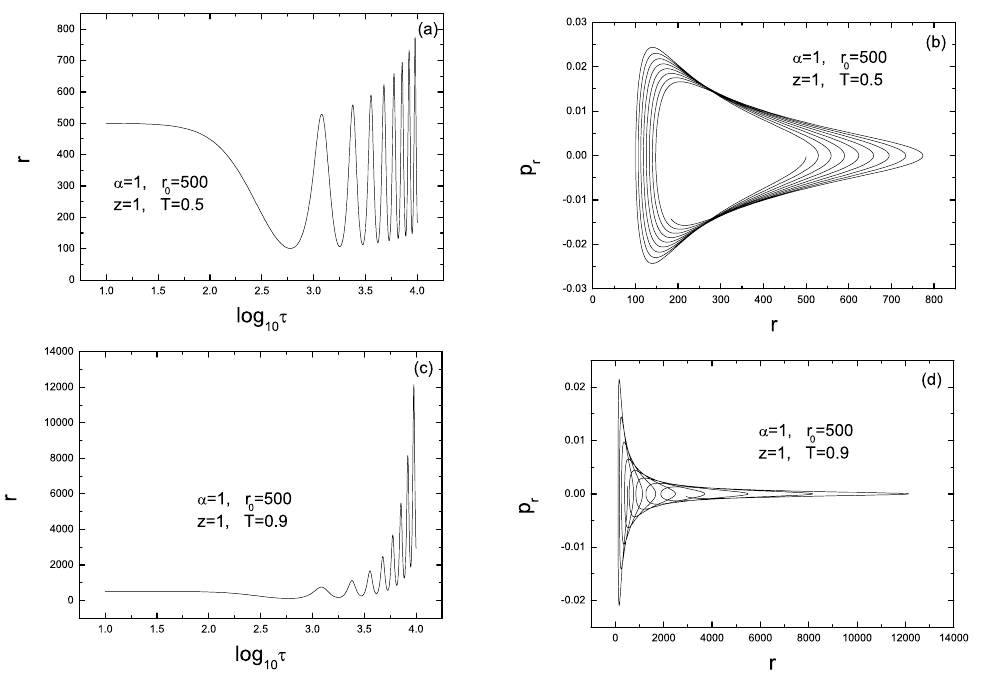
Figure 2 . The time evolution of r ( (cid:28) ) (left panels) and the phase space ( r; p r ) (right panels) with r 0 = 500 for di(cid:11)erent temperatures (the panels above are T = 0 : 5 and that below are T = 0 : 9). Here, we have set (cid:11) = 1, (cid:18) = 0, z = 1, E = 5, (cid:12) = 1 =(cid:25) , (cid:26) = 0 : 01 and p (cid:26) =